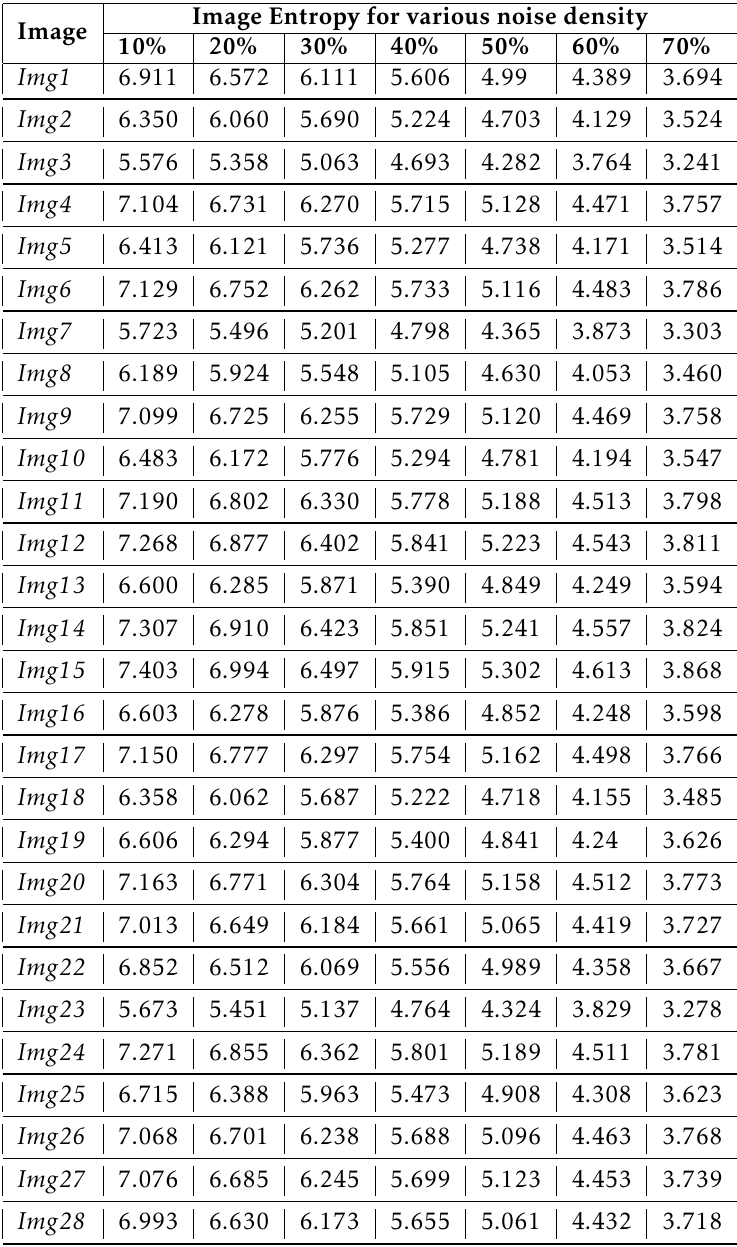
Table 1. Change in entropy with respect to noise density Image Entropy for various noise Image